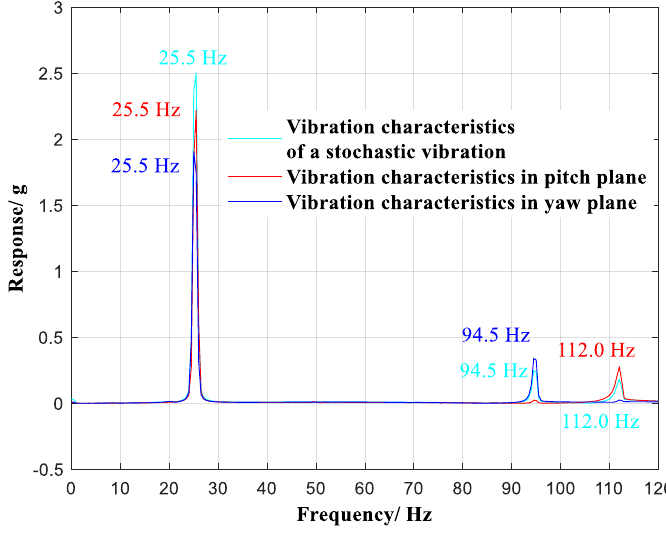
Figure 10. Comparison of vibration characteristics.